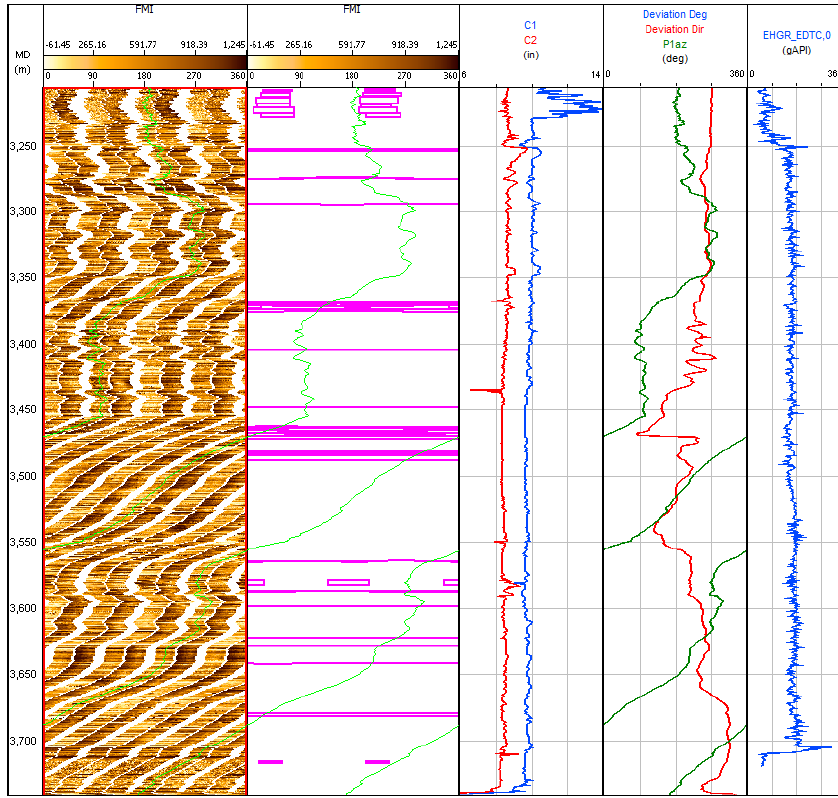
Figure 10. Wellbore breakout analysis for W205. Energies 2020 , 13 , x FOR PEER REVIEW